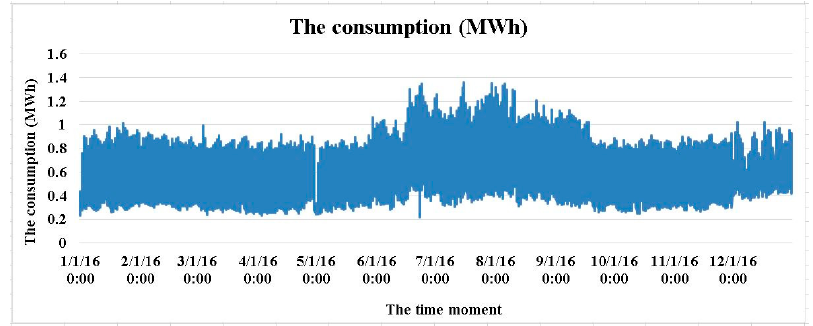
Figure 1. The consumption time series for the year 2016.